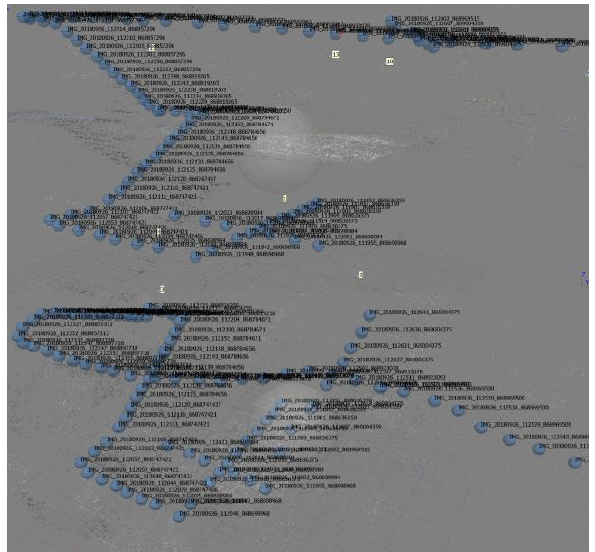
Figure 8. 3D visualization of the computed camera